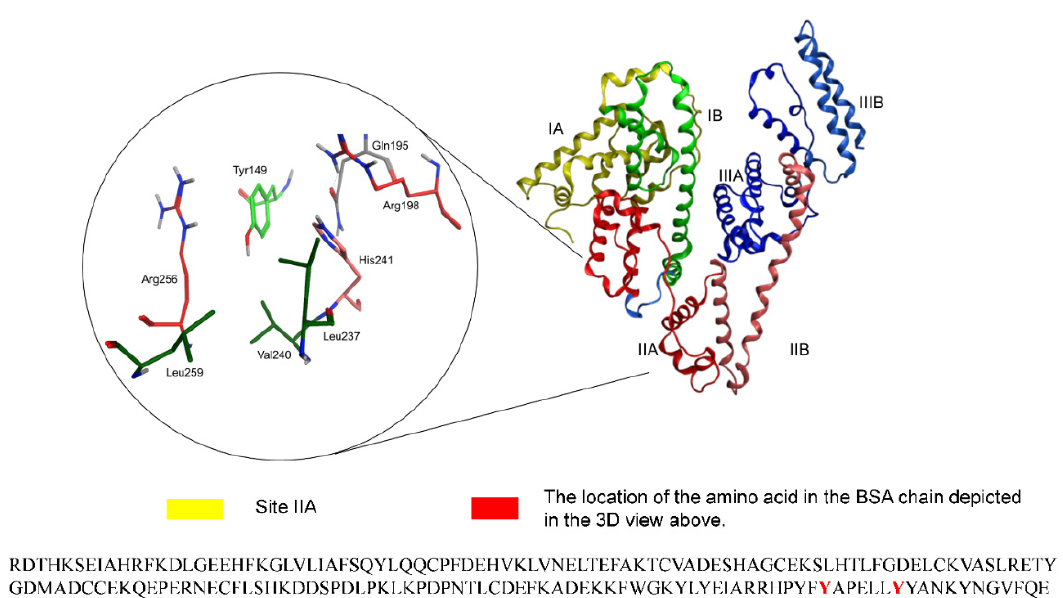
Figure 1. Domain structure of BSA site IIA and the full amino acid sequence of BSA. The heart-shaped BSA consists of 3 homologous α -helical domains (I, II, III), and each domain contains 2 subdomains (A and B). To mimic the BSA site IIA structure, QNKRFYFRKNQ (CW2 or LW2) was engineered with 4 cationic residues (2 Arg and 2 Lys), 4 polar residues (2 Asn and 2 Gln), and 3